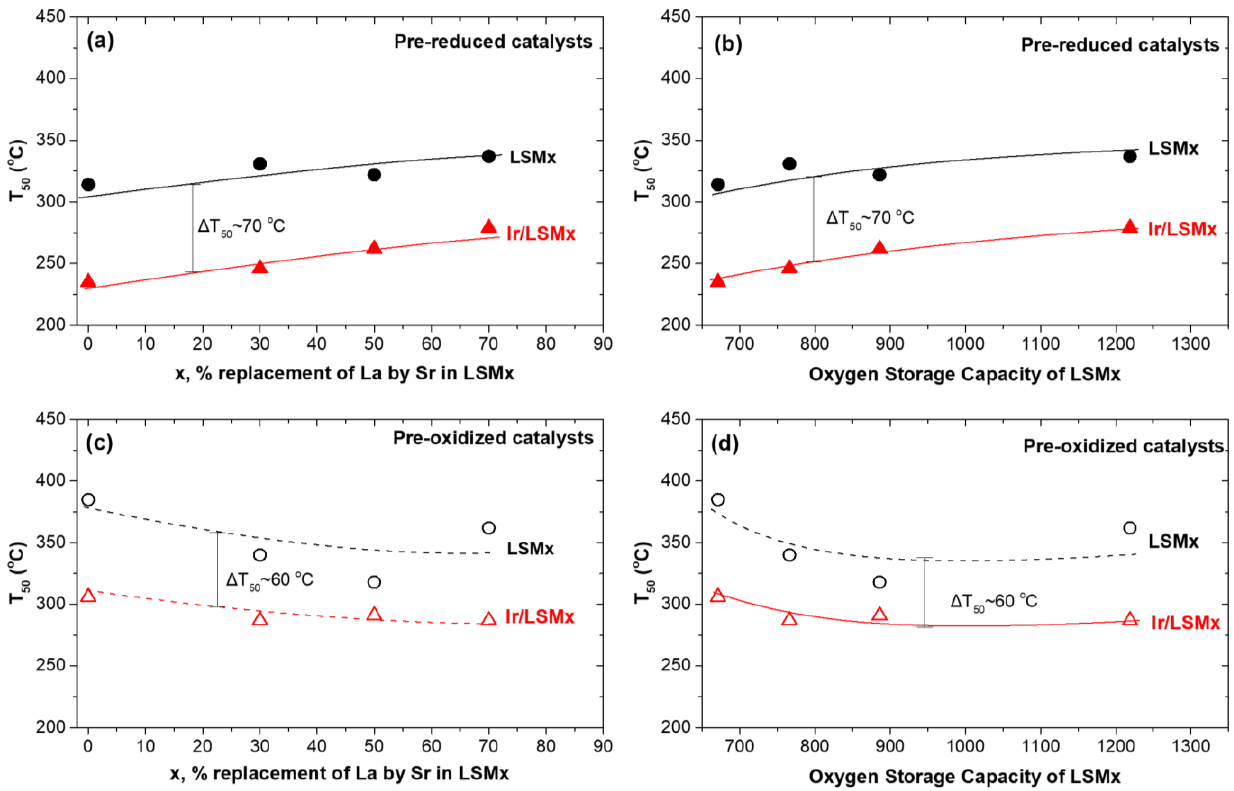
Figure 4. The temperature for 50% conversion of CO (T 50 ) achieved by LSMx (black, circles) and Ir/LSMx (red, triangles) catalysts in their prereduced ( a , b ) and preoxidized ( c , d ) states as a function of the % replacement of La by Sr ( a , c ) and OSC of the LSMx ( b , d ).